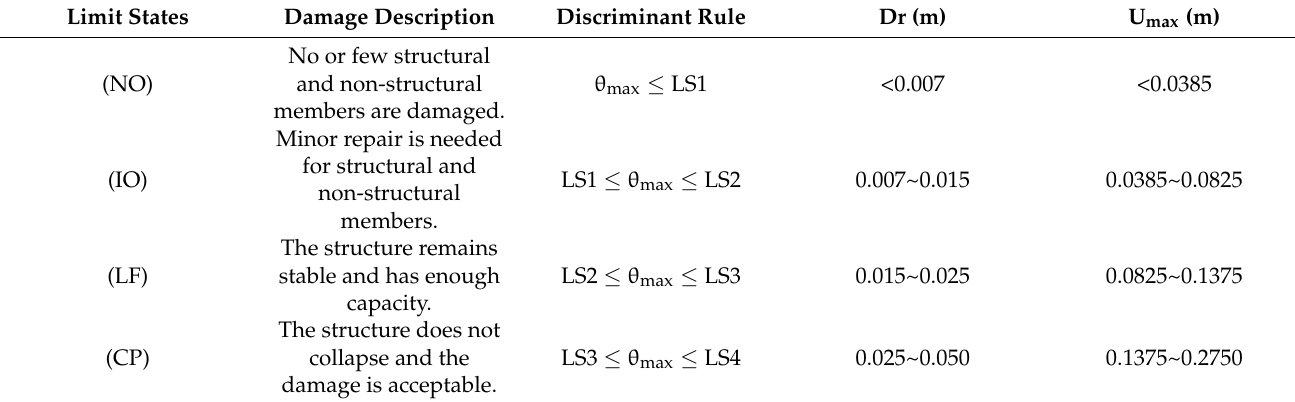
Table 5. Values of quantitative indexes correspond to structural performance levels.